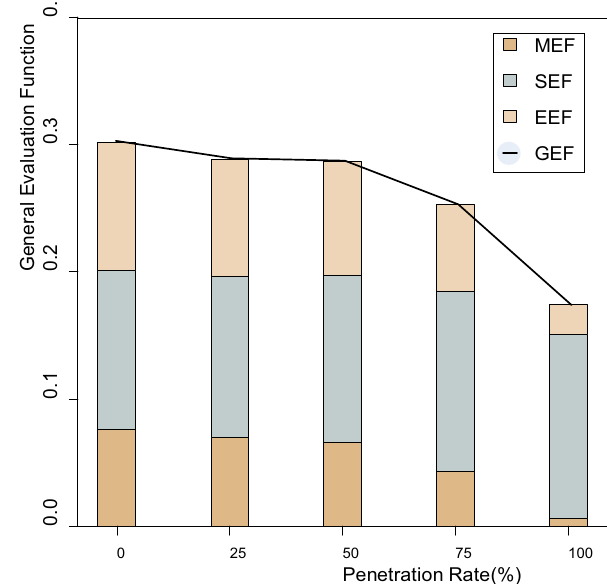
Figure 11 Changes in GEF , MEF , SEF and EEF under different